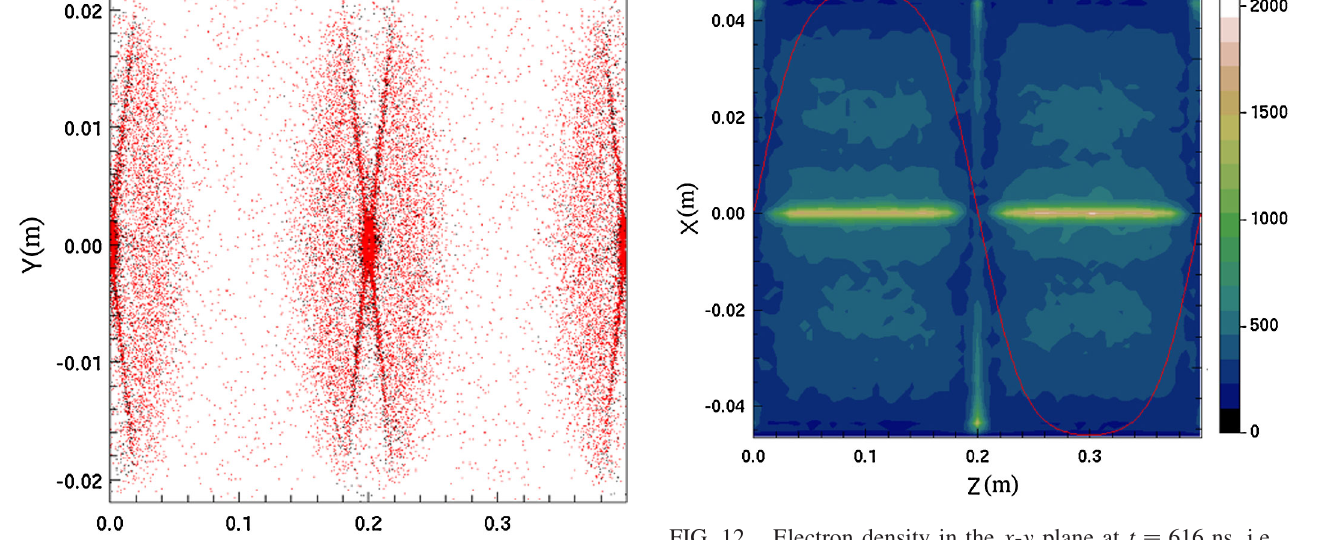
FIG. 12. Electron density in the x - y plane at t ¼ 616 ns , i.e., just before the 45th bunch passage. The sinusoidal line shows the magnitude of B y vs z at x ¼ 0 . Color bar units are arbitrary but absolute densities can be seen in Figs. 3 and